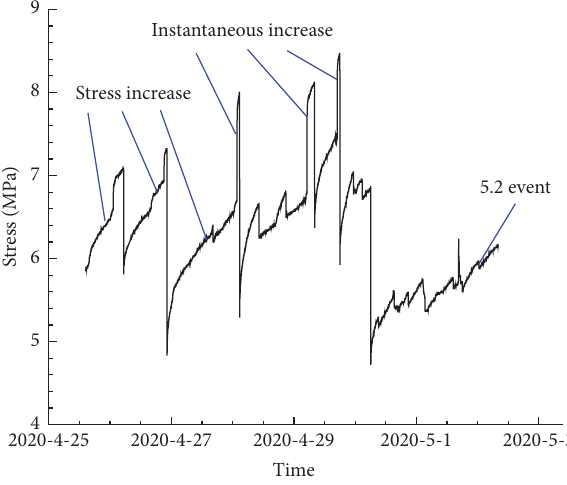
Figure 16: Borehole stress